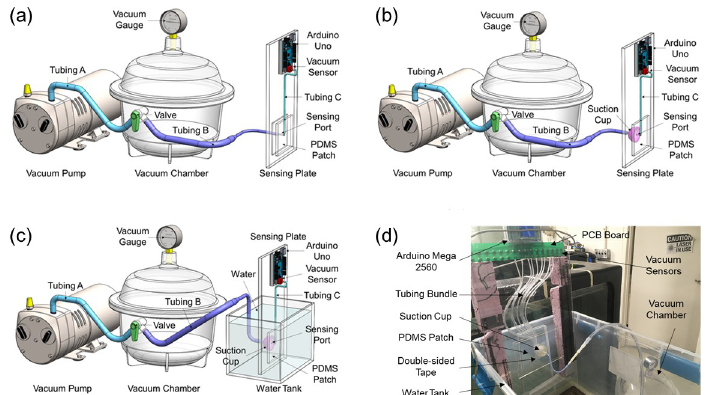
Fig 3. Schematic (not to scale) of experimental setups for checking leakage of the single- and 9-port pressure sensing systems used to measure oral suction pressures of sea lamprey, Petromyzon marinus . (a) Apply vacuum from the vacuum chamber to the vacuum sensor through tubing B, sensing port and tubing C, (b) apply vacuum from the vacuum chamber to the vacuum sensor through tubing B, suction cup attached on the plate, sensing port and tubing C, and (c) test setup (d) under water by putting part of the sensing plate and the suction cup under water in a water tank. Abbreviations: PDMS = polydimethylsiloxane; PCB = printed circuit board.